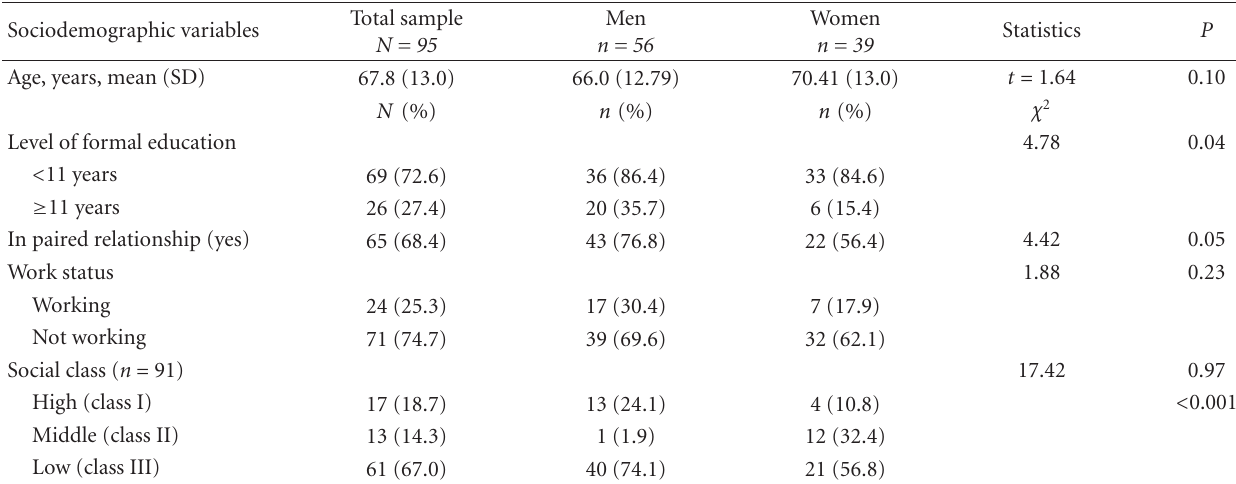
Table 1: Sociodemographic characteristics of the sample at baseline.